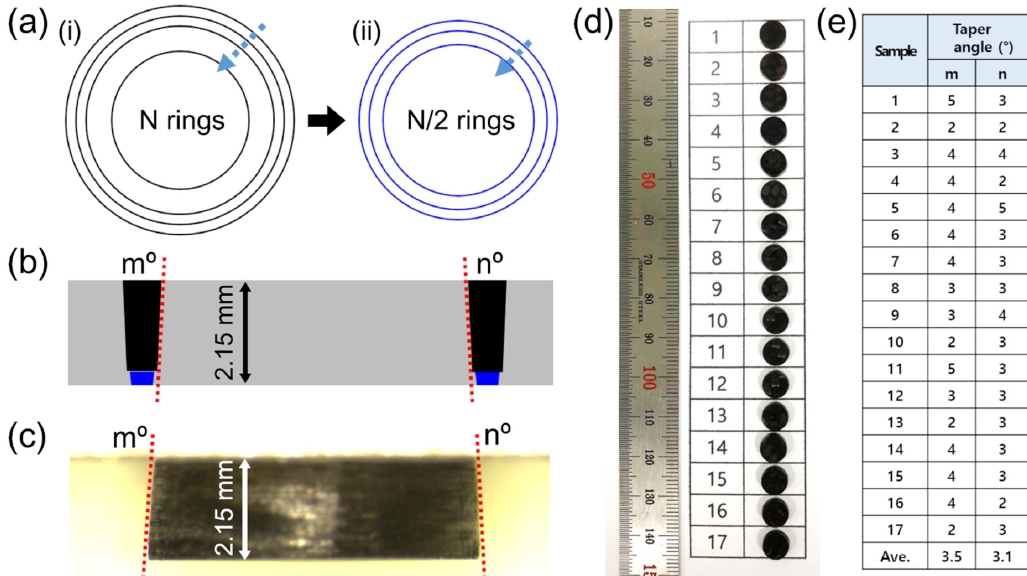
Figure 10. Taper angles of the drilled cylinder specimens of the thermoset CFRP. ( a ) Schematic of hole drilling strategy by multi-ring scanning with two-step processing. ( b ) Schematic of cross-section for the two steps of multi-ring scanning. Taper angles on left and right side correspond to m° and n°, respectively. ( c ) Stereoscopic microscope cross-section image of the laser-drilled cylinder specimen. ( d ) The photograph of 17 specimens used for investigation of taper angle. ( e ) Systematic investigation of the taper angles of the specimens as shown in ( d ). Average values are between 3° and 3.5°.